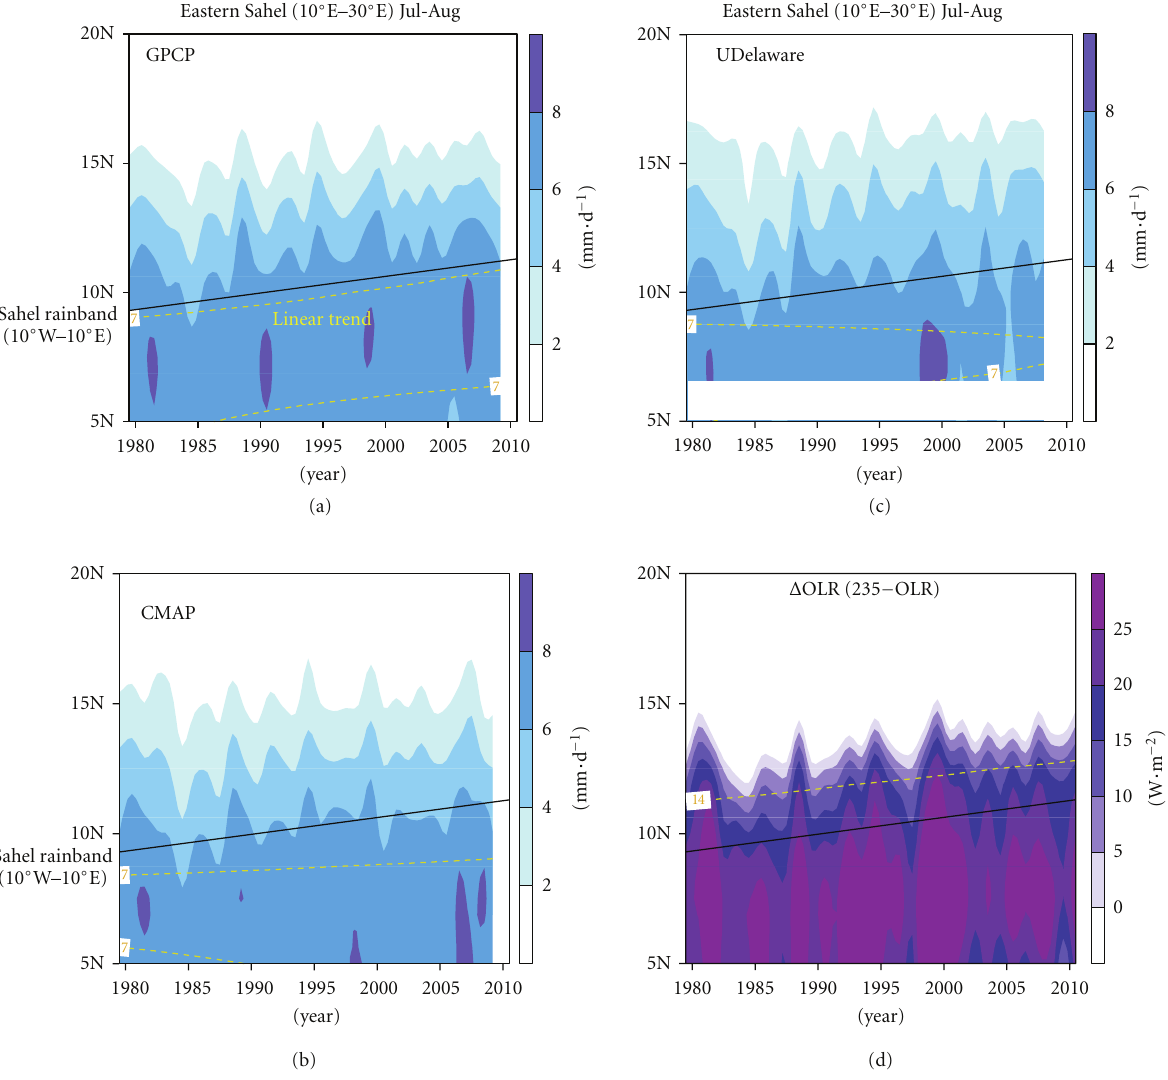
Figure 3: The same as Figure 2 but for the longitudinal zone of 10 ◦ E and 30 ◦ E (eastern Sahel). The black solid lines indicate the rainband as in Figure